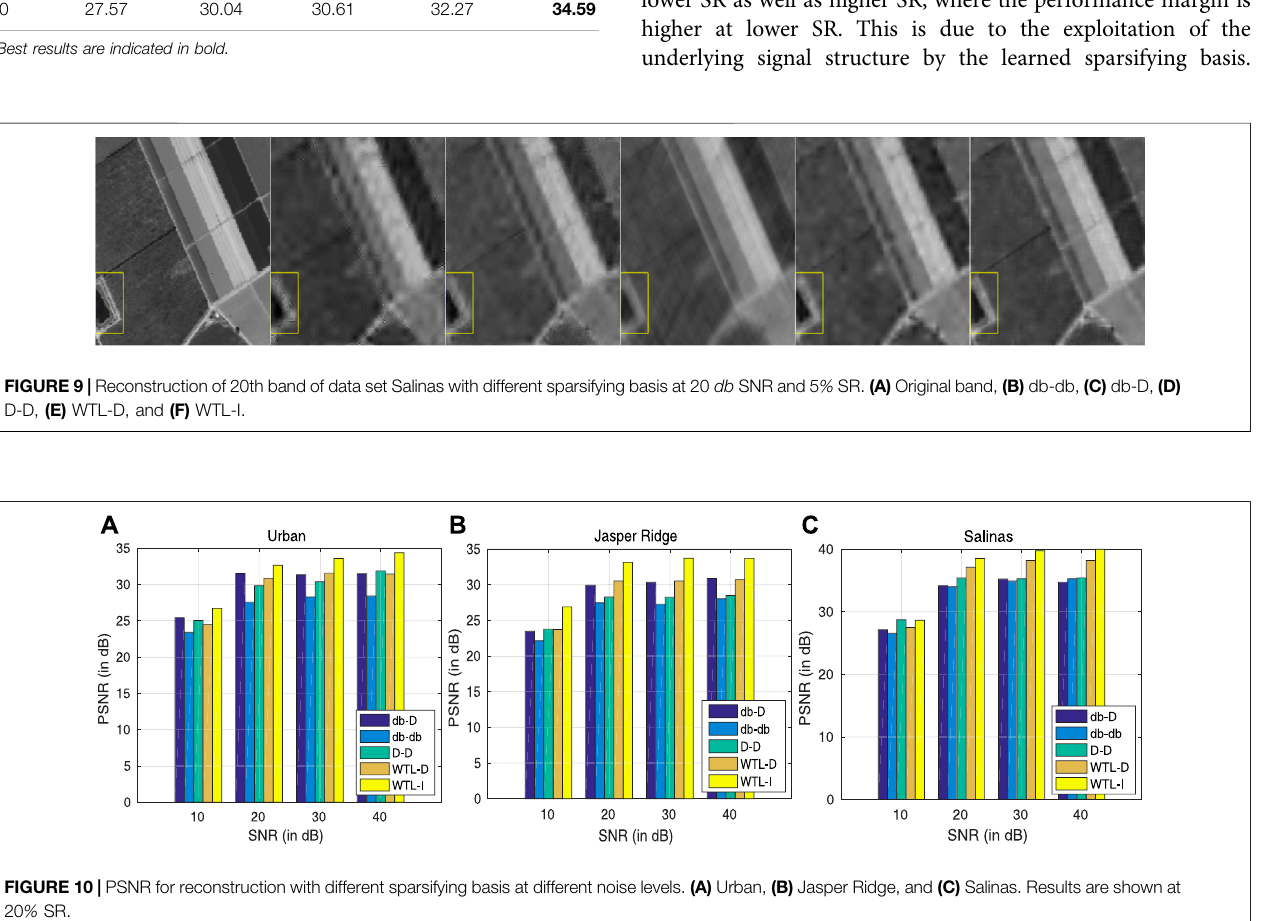
Frontiers in Signal Processing |